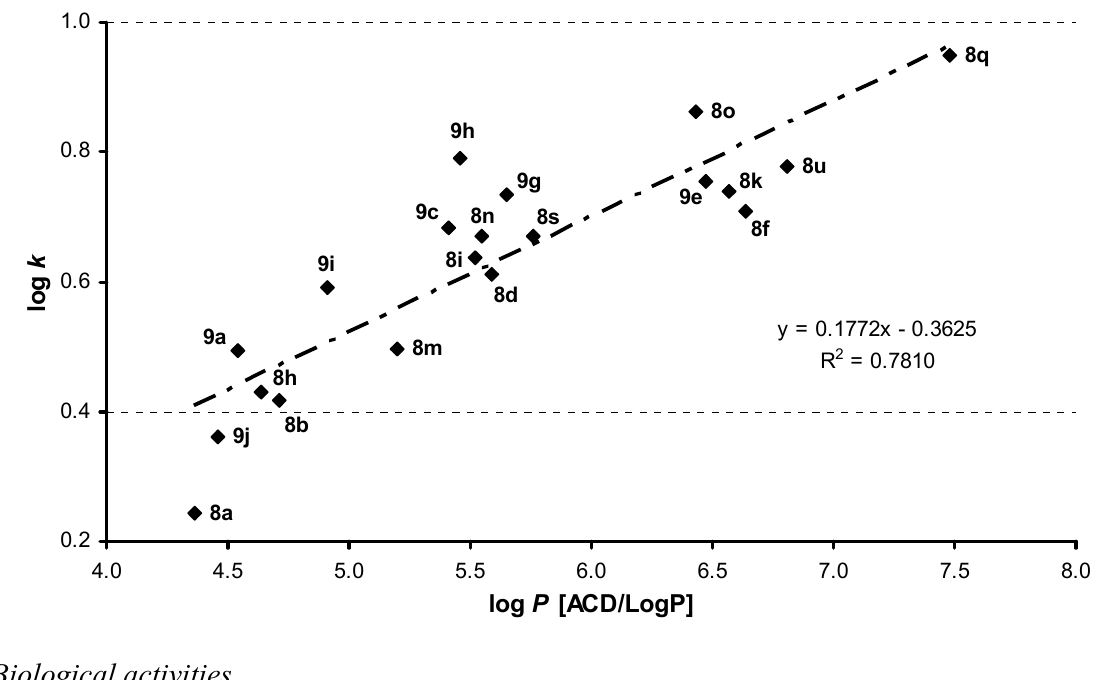
Figure 1. Relationship between calculated log P data (ACD/LogP) and experimentally found log k values. If both enantiomers were prepared, only ( S )-enantiomers are illustrated due to similar log k